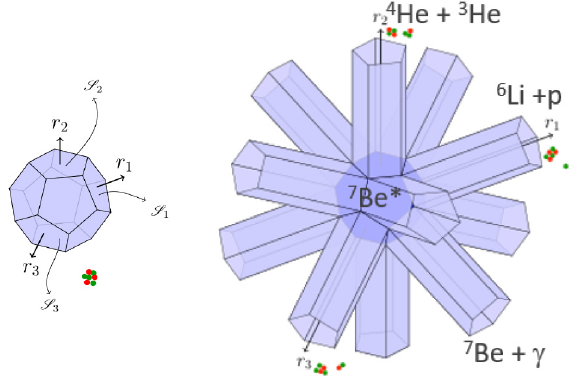
Fig. 12. Schematic view of the 7 Be compound nucleus with channel surfaces and radii (left) and formation and decay through various channels (right).